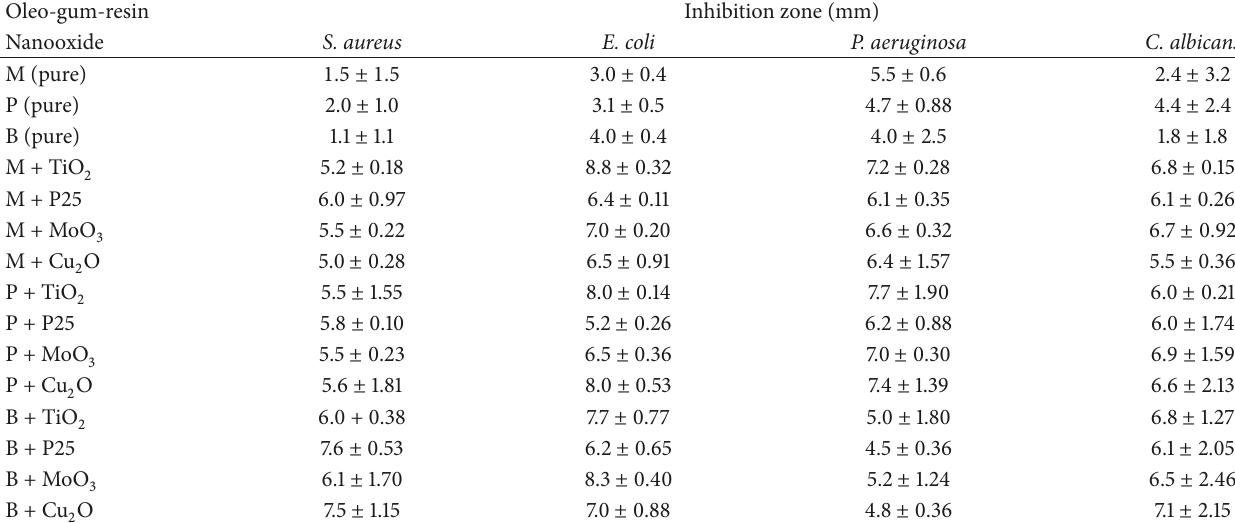
Table 1: Antibacterial activity of materials against selected pathogenic